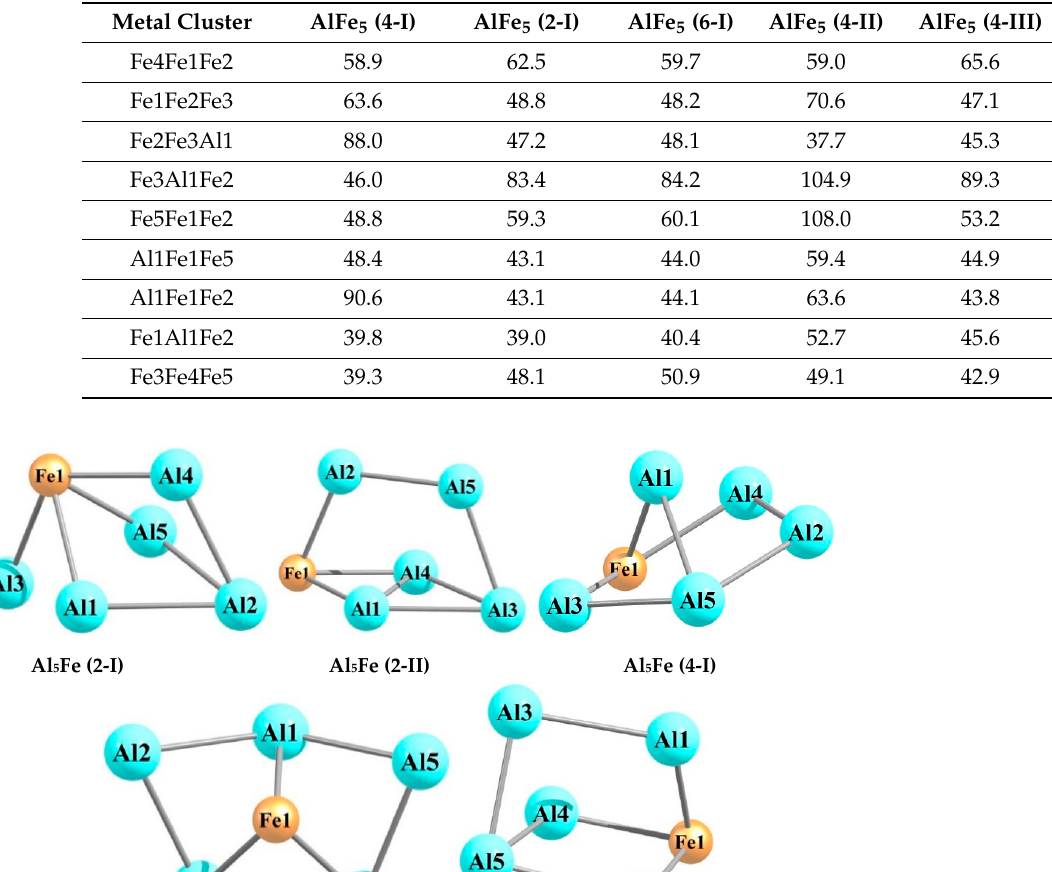
Table 1. Relative energies and spin multiplicities of the ground states of various structural isomers Table 10. Cont. of metal clusters with an Al 5 Fe composition.